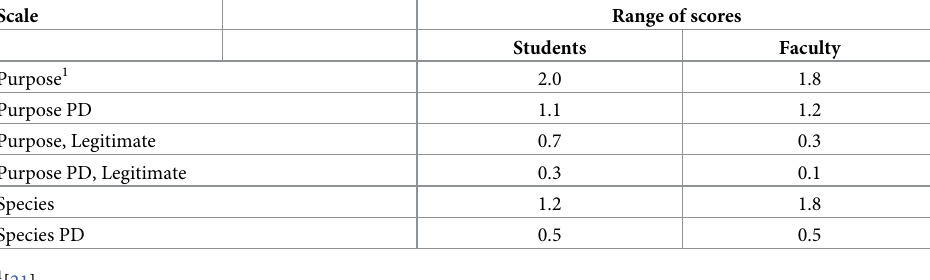
Table 9. Justifiability score midpoints and ranges for ARAS-PD scales compared to ARAS-P and ARAS-S.